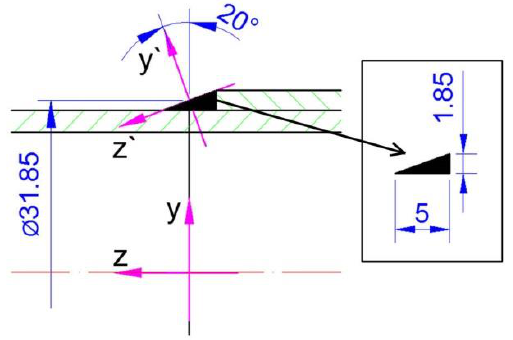
Figure 13. Scheme of the inclination of the heat source.